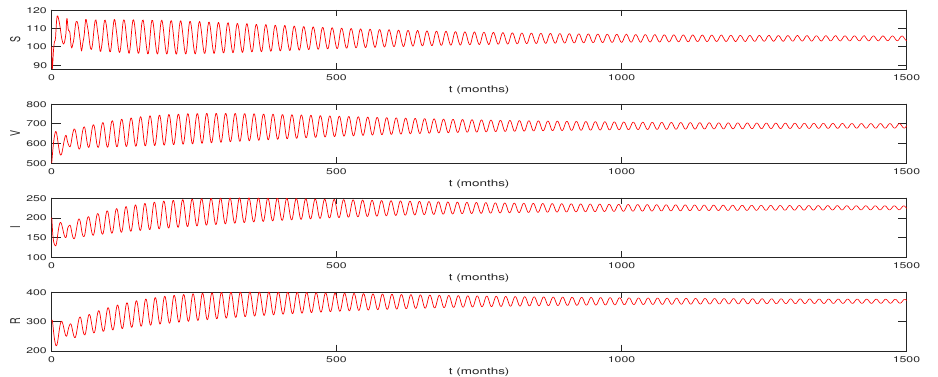
Figure 12. τ 2 ∗ = 25, τ 1 ∗ = 6, equilibrium E 2